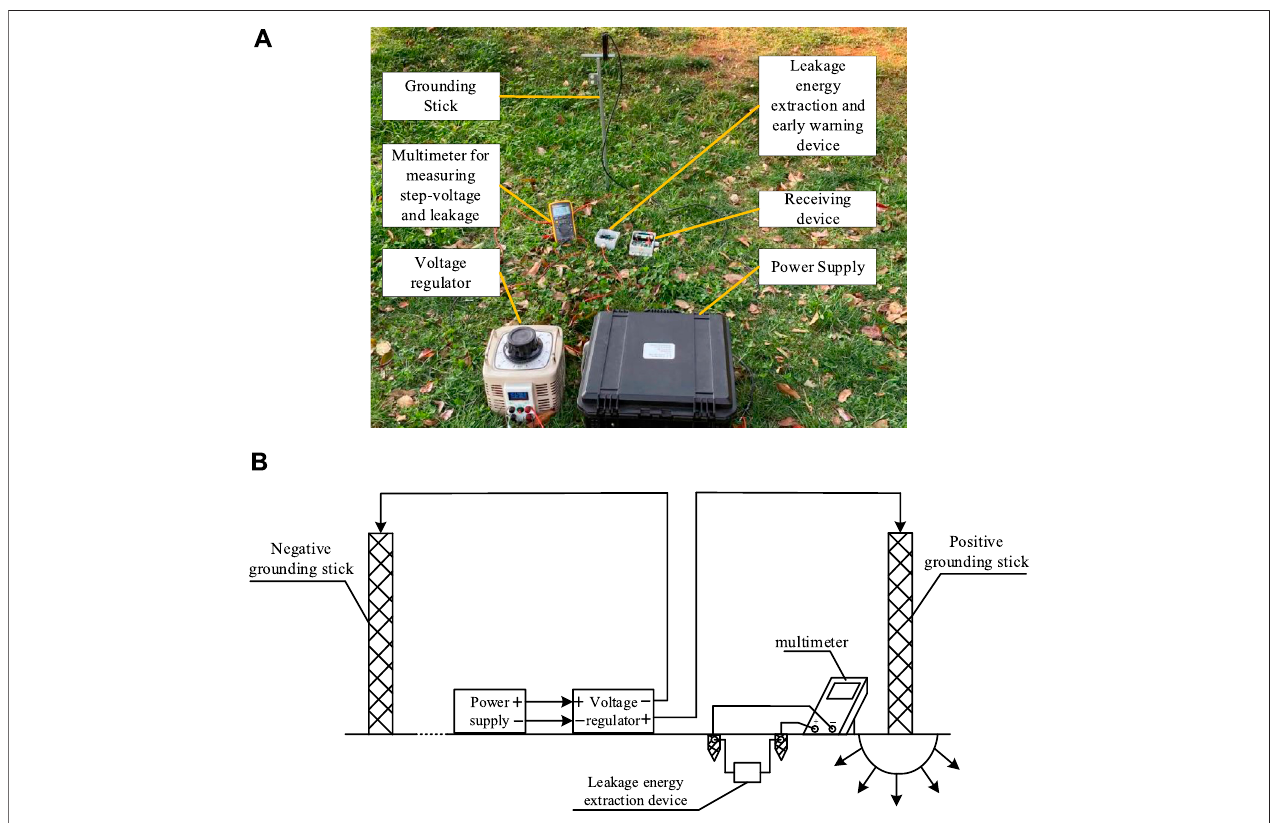
FIGURE 4 | On-site simulation experiment. (A) On-site simulation experiment of power supply and (B) block diagram of the electrical experiment.